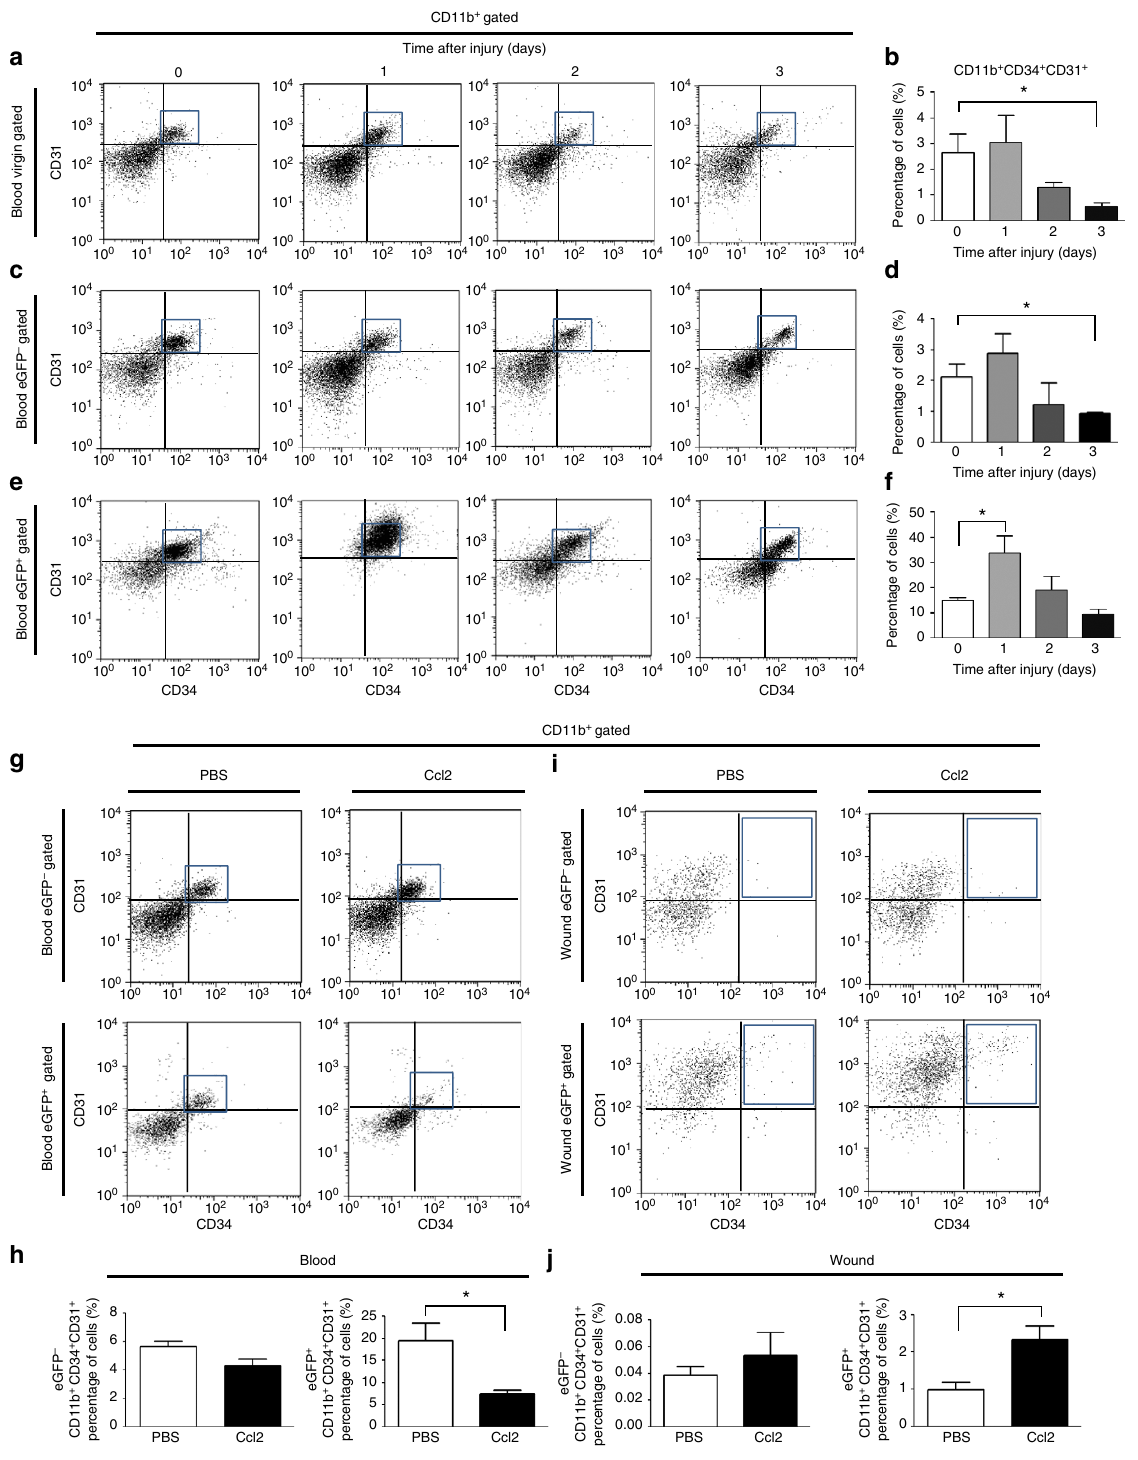
Figure 4 | Ccl2 recruits fetal MPCs to wound. Peripheral mononuclear blood cells (PBMCs) were collected from pregnant female mice carrying eGFP þ foetuses or from virgin control mice with and without wounds, on days 0–3 for FACS analysis. ( a , b ) Representative FACS results for CD34/CD31 staining in the CD11b þ gate for virgin mice, with quantification ( n ¼ 3). ( c , d ) Representative FACS results for CD34/CD31 staining in the CD11b þ gate in maternal cells (eGFP (cid:2) ) from pregnant mice, with quantification ( n ¼ 3). ( e , f ) Representative FACS results for CD34/CD31 staining in the CD11b þ gate for fetal cells (eGFP þ ) from pregnant mice ( n ¼ 3). ( b , d , f ) Percentage of CD11b þ CD34 þ CD31 þ cells. Pregnant female mice carrying eGFP þ foetuses were wounded and PBS or Ccl2 was injected into the wound immediately and 2 days after wounding. PBMCs and wounds were collected 7 days later for FACS analysis. ( g , h ) PBMCs and ( i , j ) wound tissues were analysed to determine the levels of maternal CD11b þ CD34 þ CD31 þ MPCs (eGFP (cid:2) gate) and fetal CD11b þ CD34 þ CD31 þ MPCs (eGFP þ gate) present after the administration of PBS or Ccl2. ( g , i ) Representative FACS results for CD34/CD31 staining in the CD11b þ /eGFP þ / (cid:2) gate. ( h , j ) Percentage of CD11b þ CD34 þ CD31 þ cells in the eGFP þ / (cid:2) gate ( n ¼ 4). Student’s t -test, * P o 0.05; mean ±